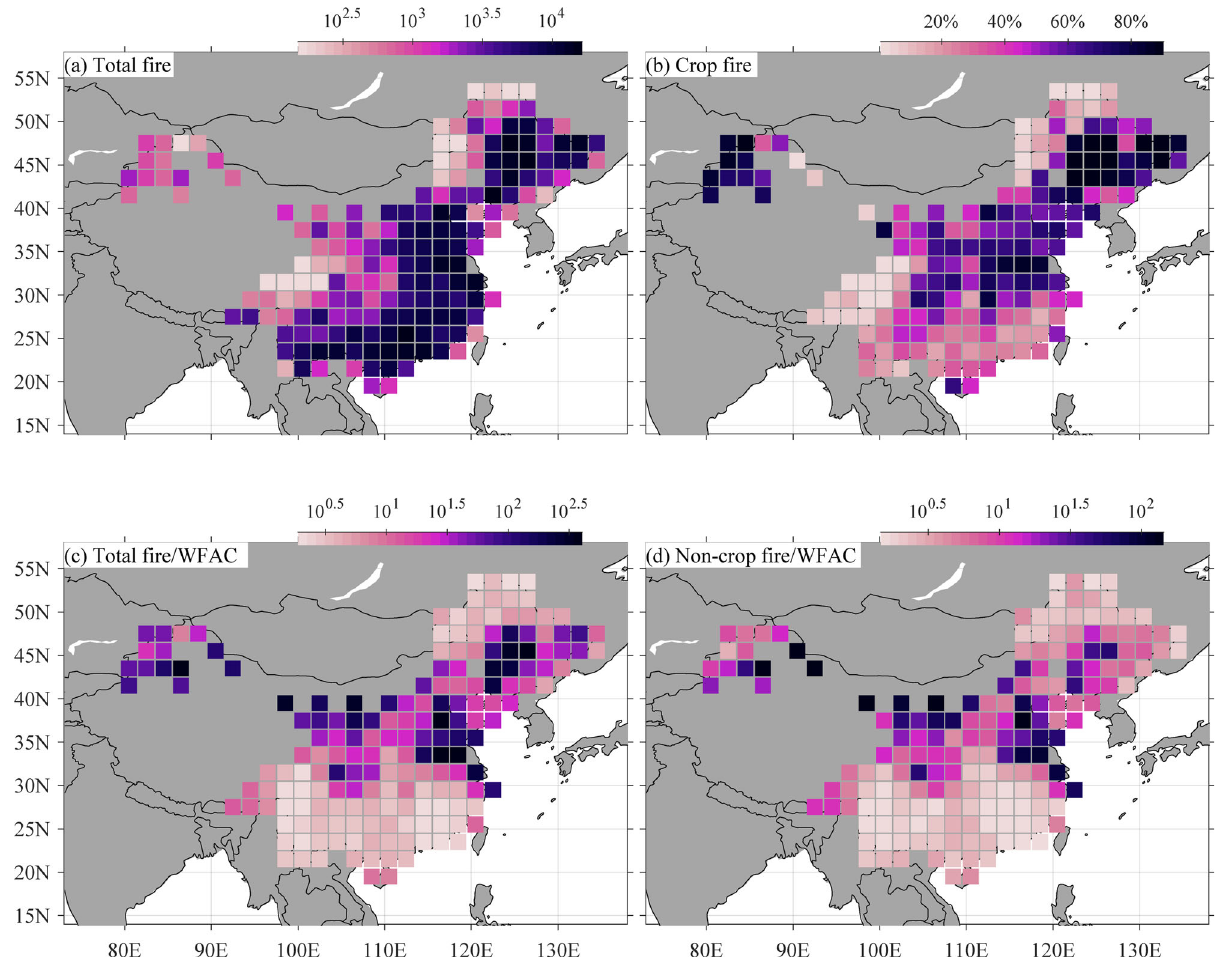
Fig. 1 | Fireoccurrencecomparisons between fi re datasets. The fi re occurrence numbers are from the Wild fi re Atlas of China (WFAC) and the Moderate Reso- lution Imaging Spectroradiometer (MODIS) data, including MOD14A1 provided by Terra and MYD14A1 provided by Aqua 4 . a Total fi re occurrences from MODIS, b crop fi re occurrences from MODIS, c the ratio between total fi re occurrences from MODIS and WFAC, and d the ratio between non-crop fi re